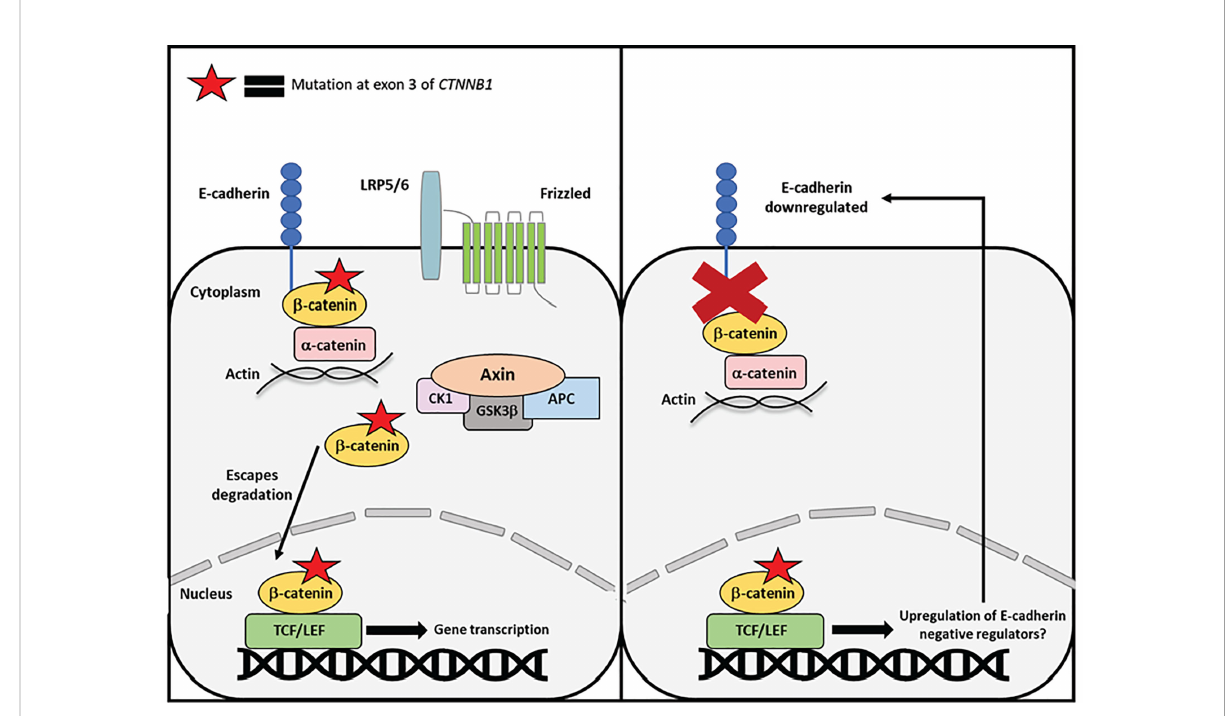
FIGURE 4 Proposed mechanism of exon 3 CTNNB1 mutations in endometrial cancer. Mutant b -catenin can escape degradation in the cytoplasm and translocate to the nucleus independent of Wnt-signaling. One mechanism by which mutant b -catenin may drive endometrial cancer is by inducing transcription of E-cadherin negative regulators or EMT genes. b -catenin mutations occur relatively early in endometrial cancer progression, whereas loss of E-cadherin occurs later in disease progression. Therefore, mutations to b -catenin may indirectly contribute to E- cadherin loss and EMT